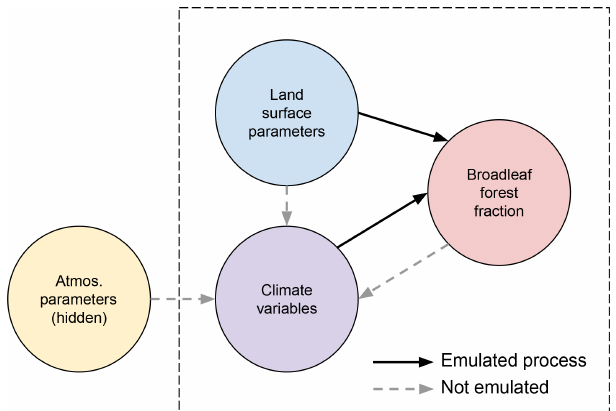
Figure 4. A graph showing the assumed relationship between input parameters, climate variables and forest fraction. An arrow indicates influence in the direction of the arrow. Processes that are directly emulated are shown with a solid arrow, while the processes shown by a dotted arrow are not directly